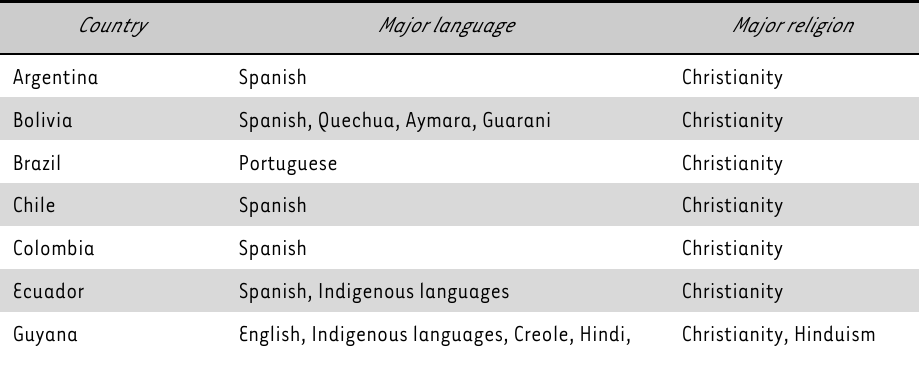
South African and South American languages and